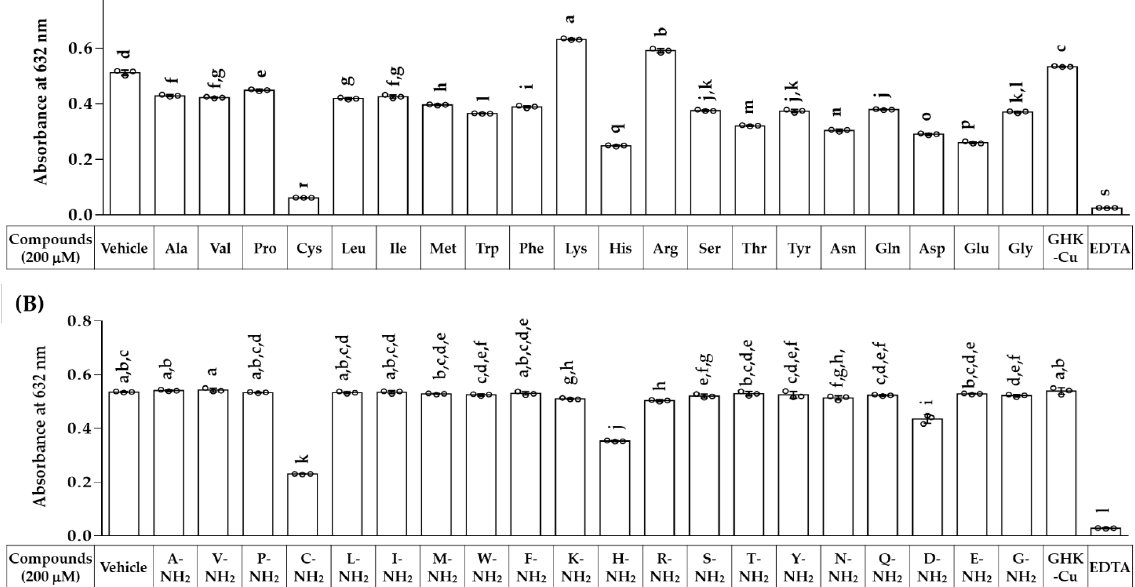
Figure 1. Copper-chelating activities of free amino acids ( A ) and amidated amino acids ( B ). The reaction mixture consisting of 200 μM CuSO 4 , 200 μM PCV, and test material at the specified concentrations was incubated for 20 min and the formation of Cu(II)-PCV complex was measured using the absorbance at 632 nm (A 632 ). Ethylenediamine-N,N,N’,N’-tetraacetic acid (EDTA) and glycyl-histidyl-lysine-copper (GHK-Cu) were used for comparative purposes. Free amino acids are denoted using three-letter codes and amidated amino acids are denoted using one-letter codes with an amine group (NH 2 ). Data represent mean ± SD (n = 3). Different lowercase letters (a–s) indicate significantly different means at the p < 0.05